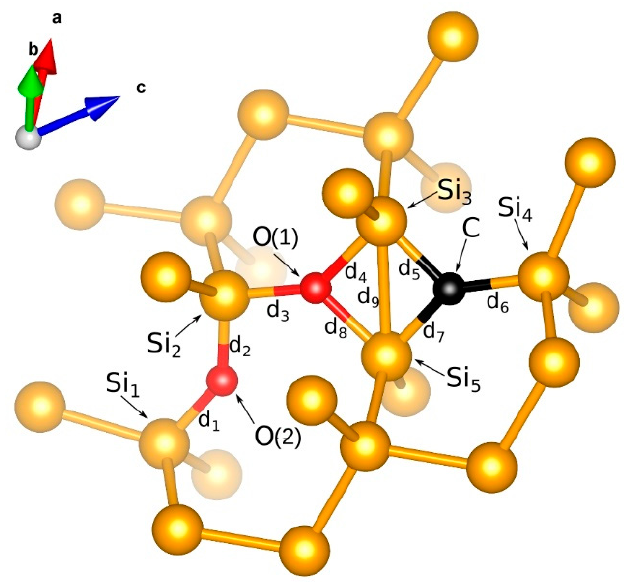
Figure 3. Schematic representation of the energetically favorable C i O 2i defect. Bond distance values are: d 1 = 1.665 Å, d 2 = 1.626 Å, d 3 = 1.711 Å, d 4 = 1.818 Å, d 5 = 1.765 Å, d 6 = 1.781 Å, d 7 = 1.782 Å, d 8 = 1.809 Å, d 9 = 2.571 Å. Angle values are: Si 1 –O(2)–Si 2 = 140.85 ◦ , O(2)–Si 2 –O(1) = 99.04 ◦ , Si 2 –O(1)–Si 3 = 140.24 ◦ ,